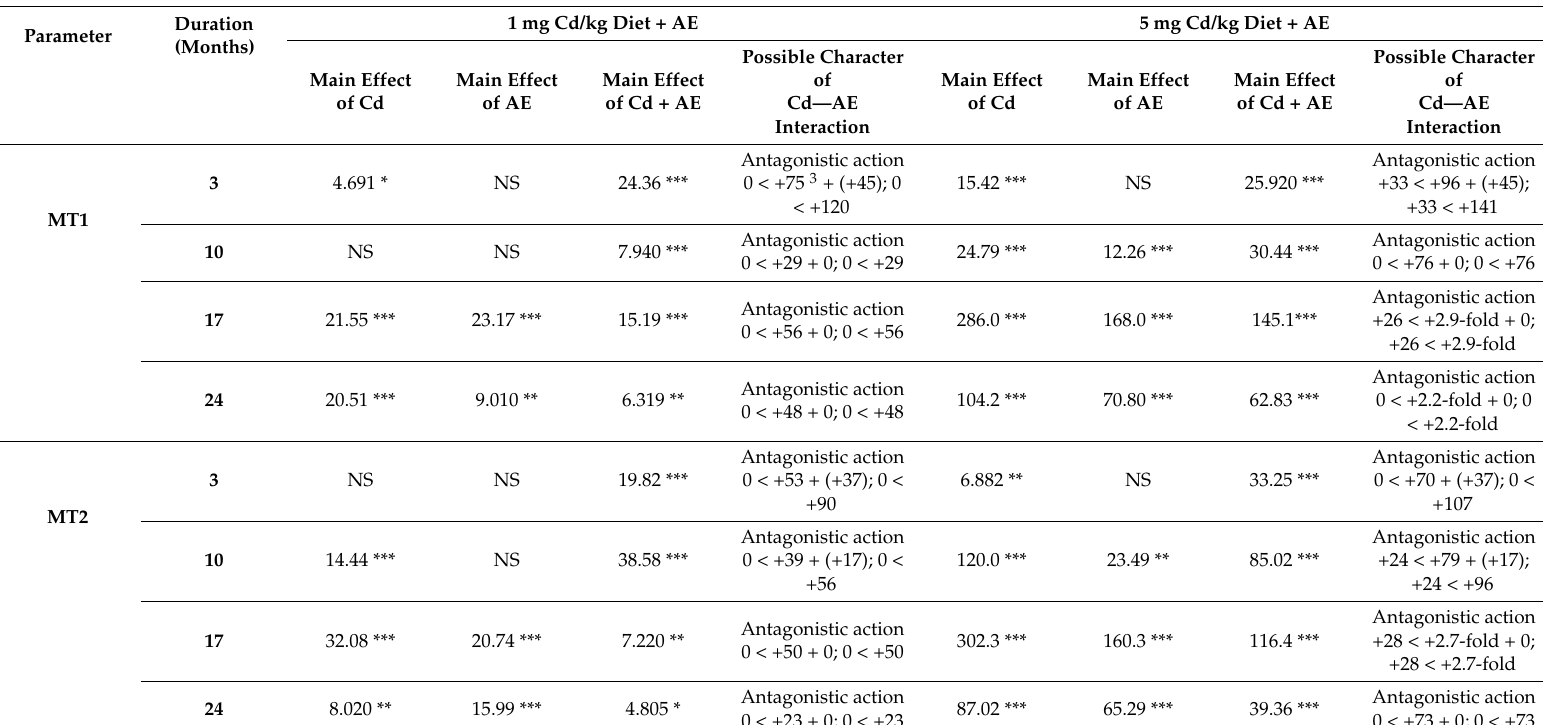
Table 4. Main and interactive effects of cadmium (Cd) and the extract from Aronia melanocarpa L. berries (AE) on the expression of metallothionein 1 (MT1) and metallothionein 2 (MT2) in the liver of female rats. 1,